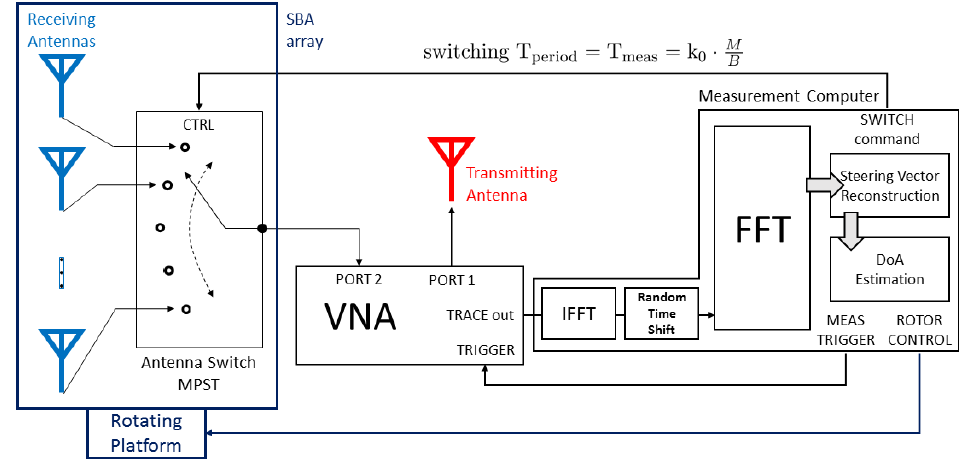
Figure 10. Block diagram of the experiment setup. The transmitting antenna emulates the